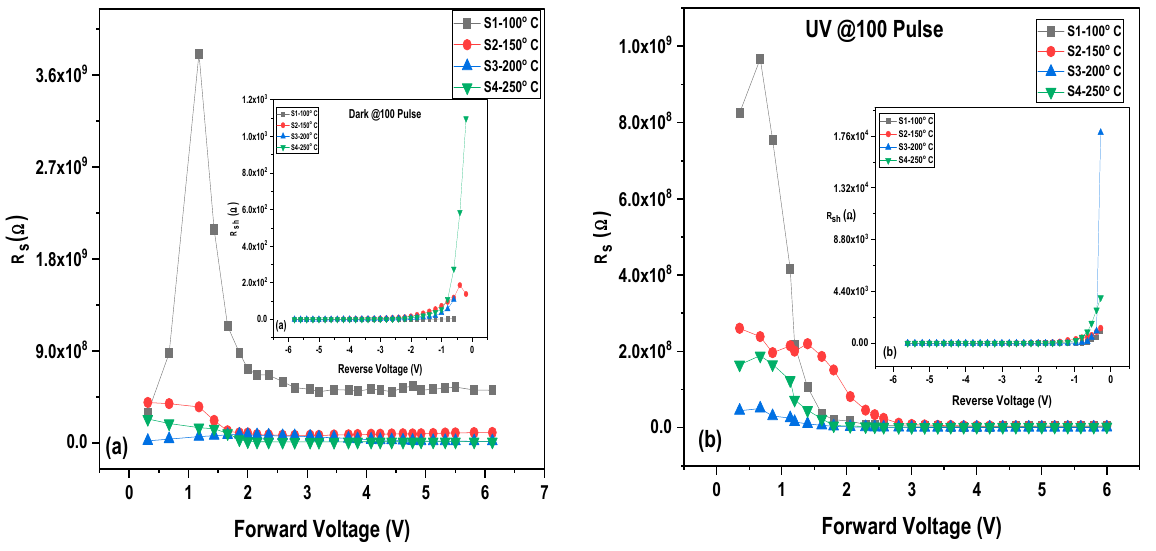
Forward Voltage (V) Figure 12. Series resistance and inset shunt resistance of MoO 3 /Si at dark (a) and UV illumination Figure 12. Series resistance and inset shunt resistance of MoO 3 /Si at dark ( a ) and UV illumination ( b (b).